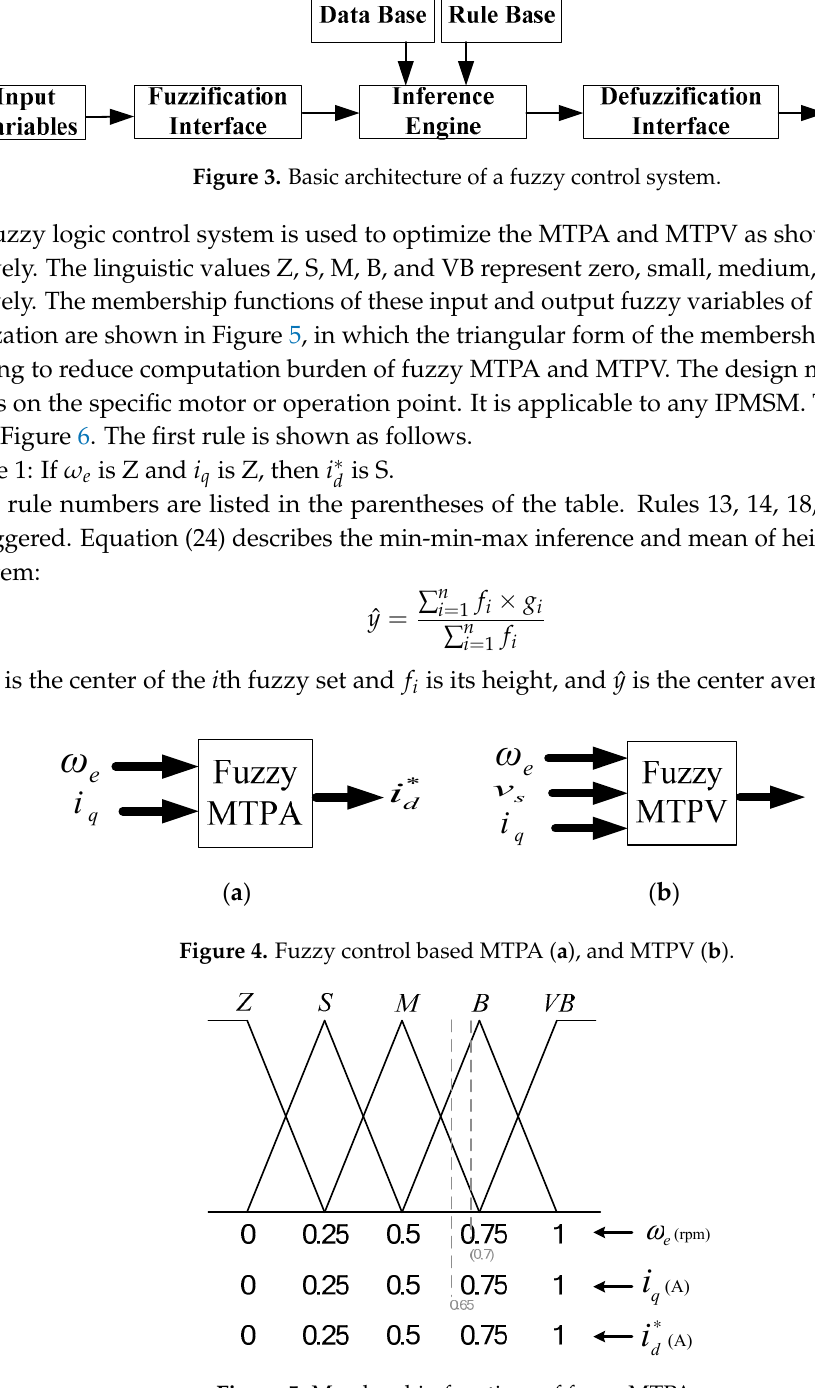
Figure 3. Basic architecture of a fuzzy control system.